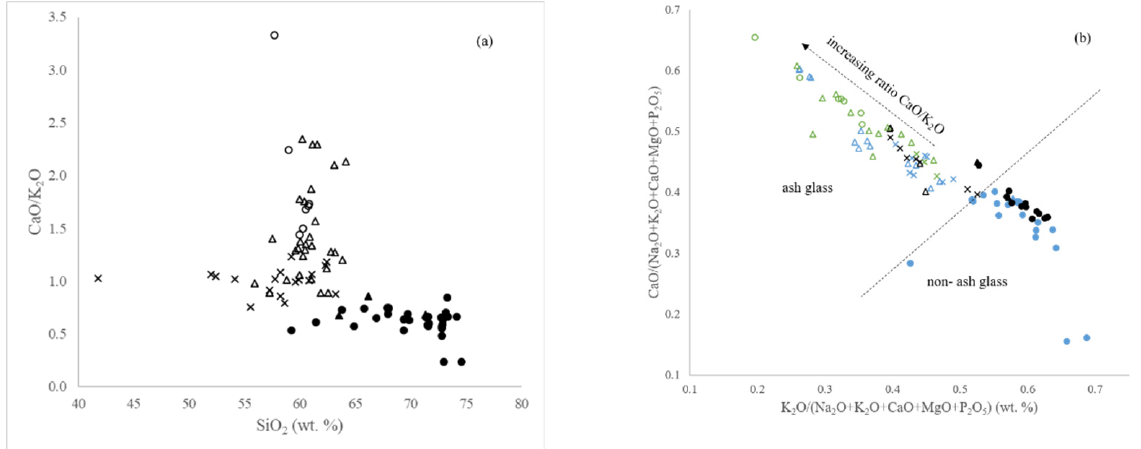
Figure 2. ( a ) Plot of CaO/K 2 O against SiO 2 for potassium–calcium glass, ash and non-ash glass (full symbols). The graph shows an increasing trend in the values of CaO/K 2 O in ash glasses and a general increase in SiO 2 over time. ( b ) Dependence of selected silicate network modifiers. The samples are differentiated by colours—green, blue and colourless (the colourless samples are represented by black colour/black symbols). Symbols: × —medieval ash glass, ∆ —early modern ash/Renaissance glass, ○ —modern age ash glass, ▲ —early modern/Renaissance non-ash glass, ● —modern age non- ash glass. Details concerning the samples are provided in the supplementary file, Table S1.